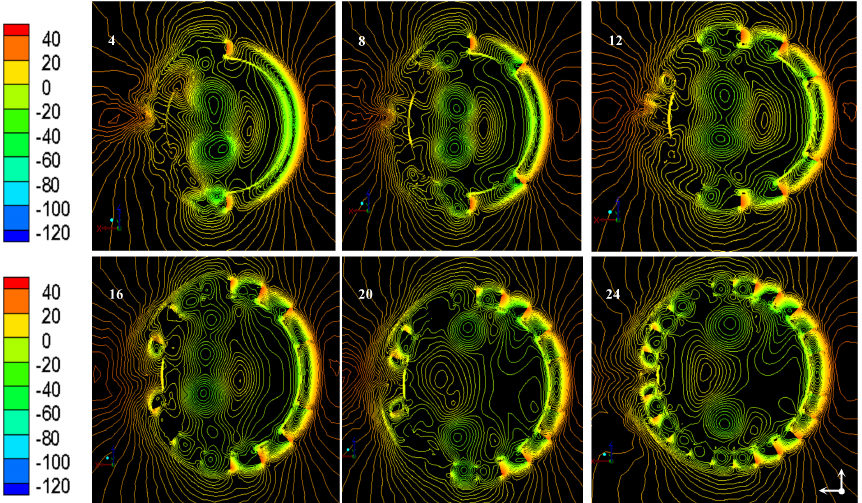
Figure 16. Contours of static pressure (unit: Pa) of air at the tower inlet with various wind deflectors under a crosswind speed of 5